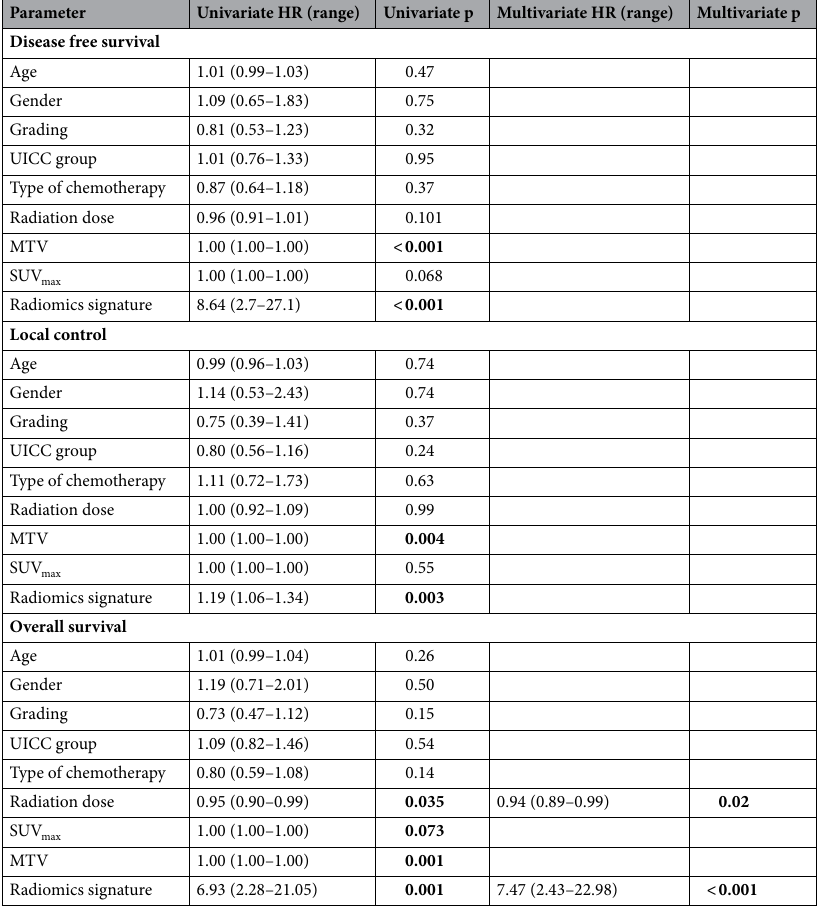
Table 1. Training cohort. Univariate and multivariate cox regression analyses of clinical parameters, treatment characteristics, the conventional PET parameter metabolic tumor volume (MTV) and radiomics signatures with respect to DFS, LC and OS. Due to the high correlation of radiomics signatures and MTV only radiomic signatures were included in multivariate analysis.